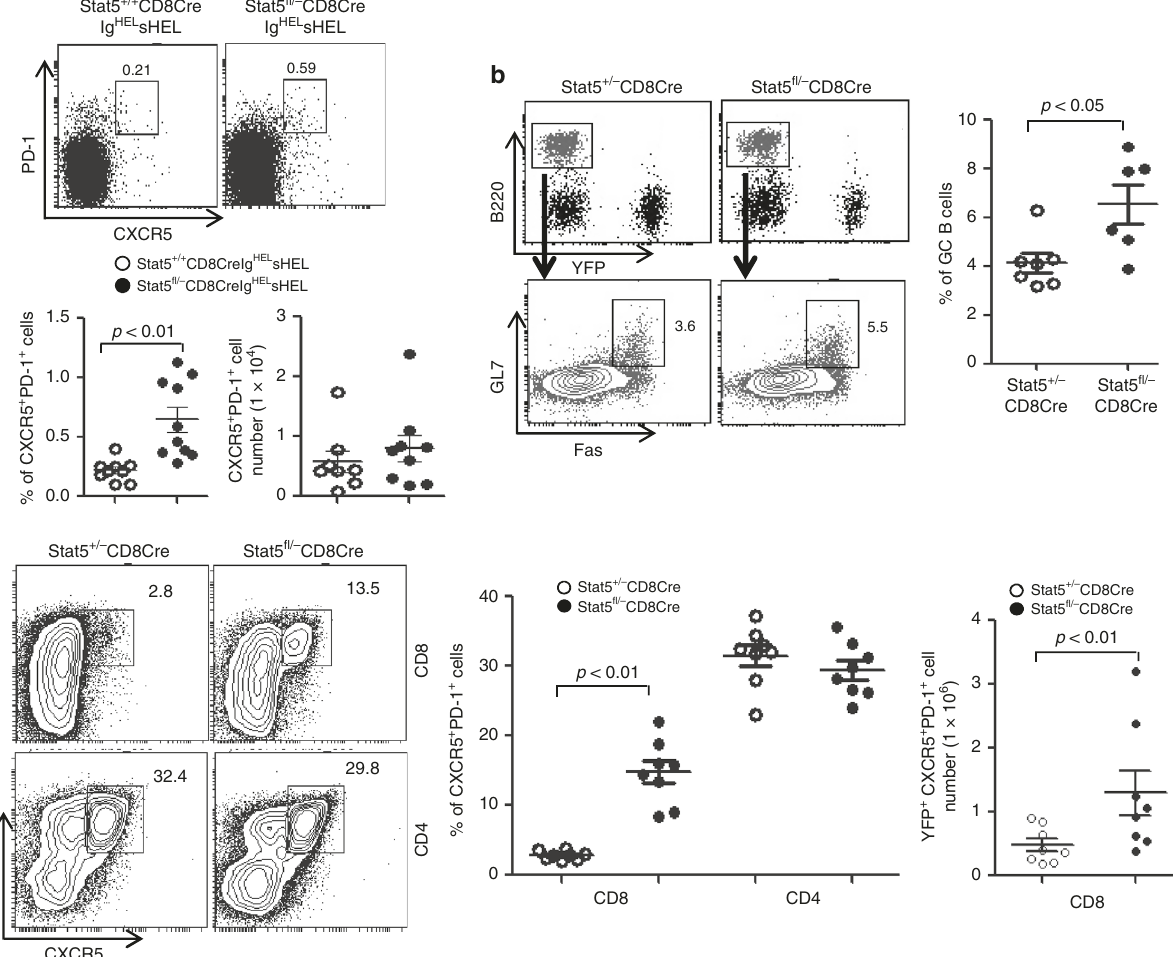
Fig. 3 Increased CD8 + Tfh and GC B cells in mice with CD8-speci fi c de fi ciency of Stat5. a Stat5 de fi ciency in CD8 + T cells markedly increases the percentage of CXCR5 + PD-1 + CD8 + T cells in Ig HEL sHEL transgenic mice. Splenocytes from Stat5 + / + CD8CreIg HEL sHEL and Stat5 fl / − CD8CreIg HEL sHEL mice were stained with anti-CD4, anti-CD8, anti-CD44, anti-CXCR5 and anti-PD-1 antibodies. Numbers indicate percentages of CXCR5 + PD-1 + cells in the gated CD4 + or CD8 + population (upper and lower left) or CXCR5 + PD-1 + CD8 + T cell numbers (lower right) and each dot represents an individual mouse (lower). Mean ± SD is shown. b Increased GC B cells in Stat5 fl / − CD8Cre mice following acute LCMV infection. Stat5 + / − CD8Cre and Stat5 fl / − CD8Cre mice were infected with LCMV. Eight days after infection, splenocytes were stained with anti-B220, anti-Fas and anti-GL7 antibodies. Numbers indicate percentages of Fas + GL7 + cells in the gated B220 + population (left) and each dot represents an individual mouse (right). Mean ± SD is shown. c